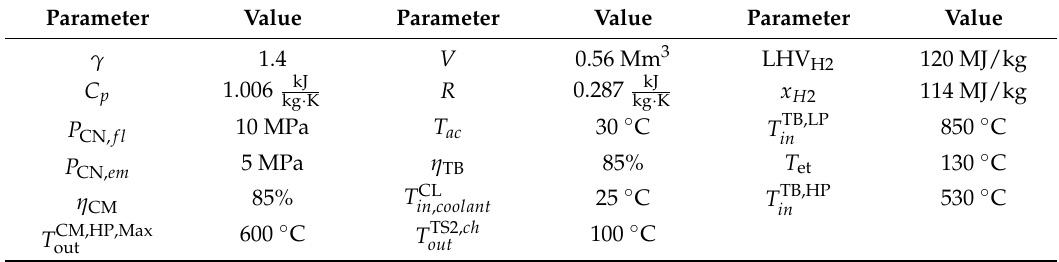
Table 1. Inputs for analysis of the A-CAES and CAES-HTE systems in the base case. The conventional CAES and CAES-LTE systems use the same values with the main exception that the maximum storage pressure is 7 MPa instead of 10 MPa.